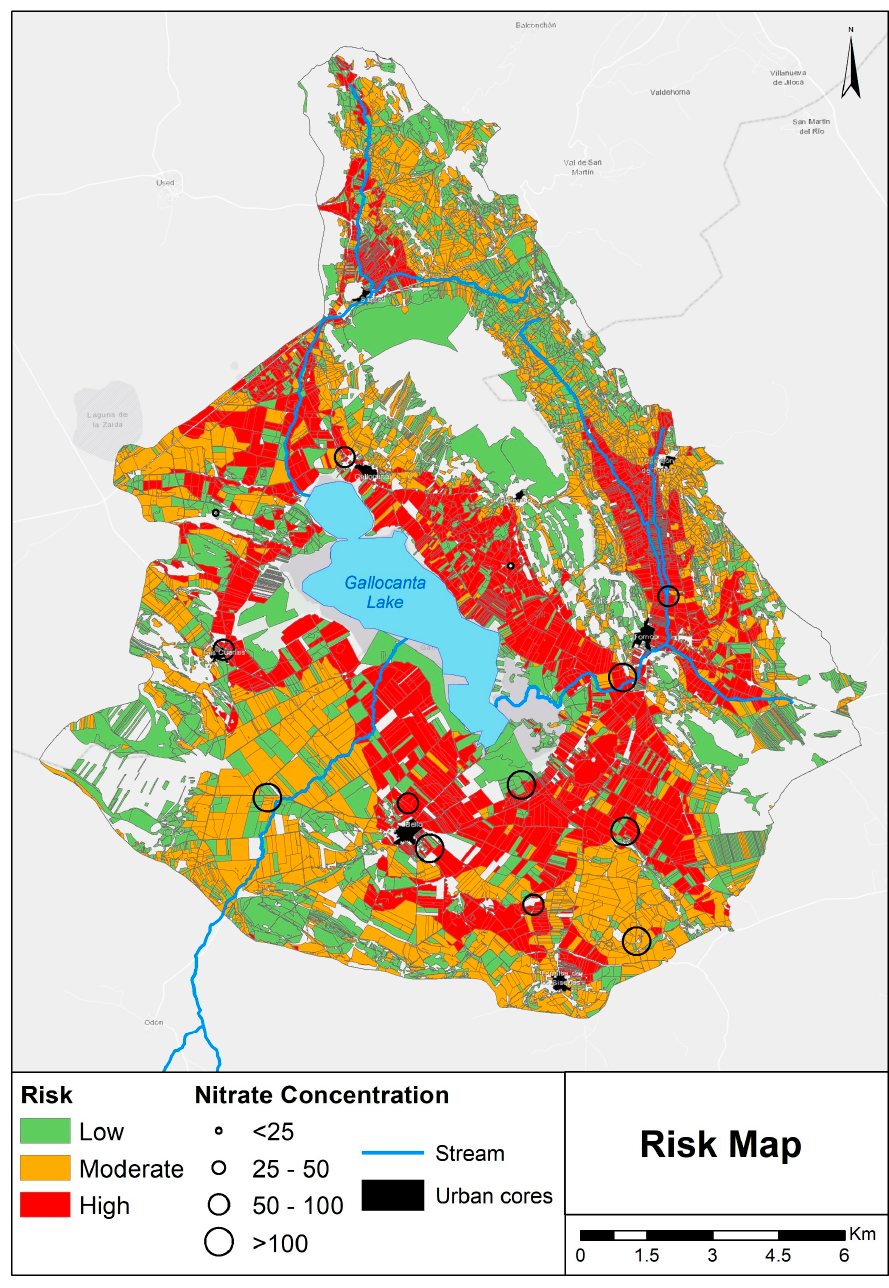
Figure 5. Risk map and nitrate concentration.